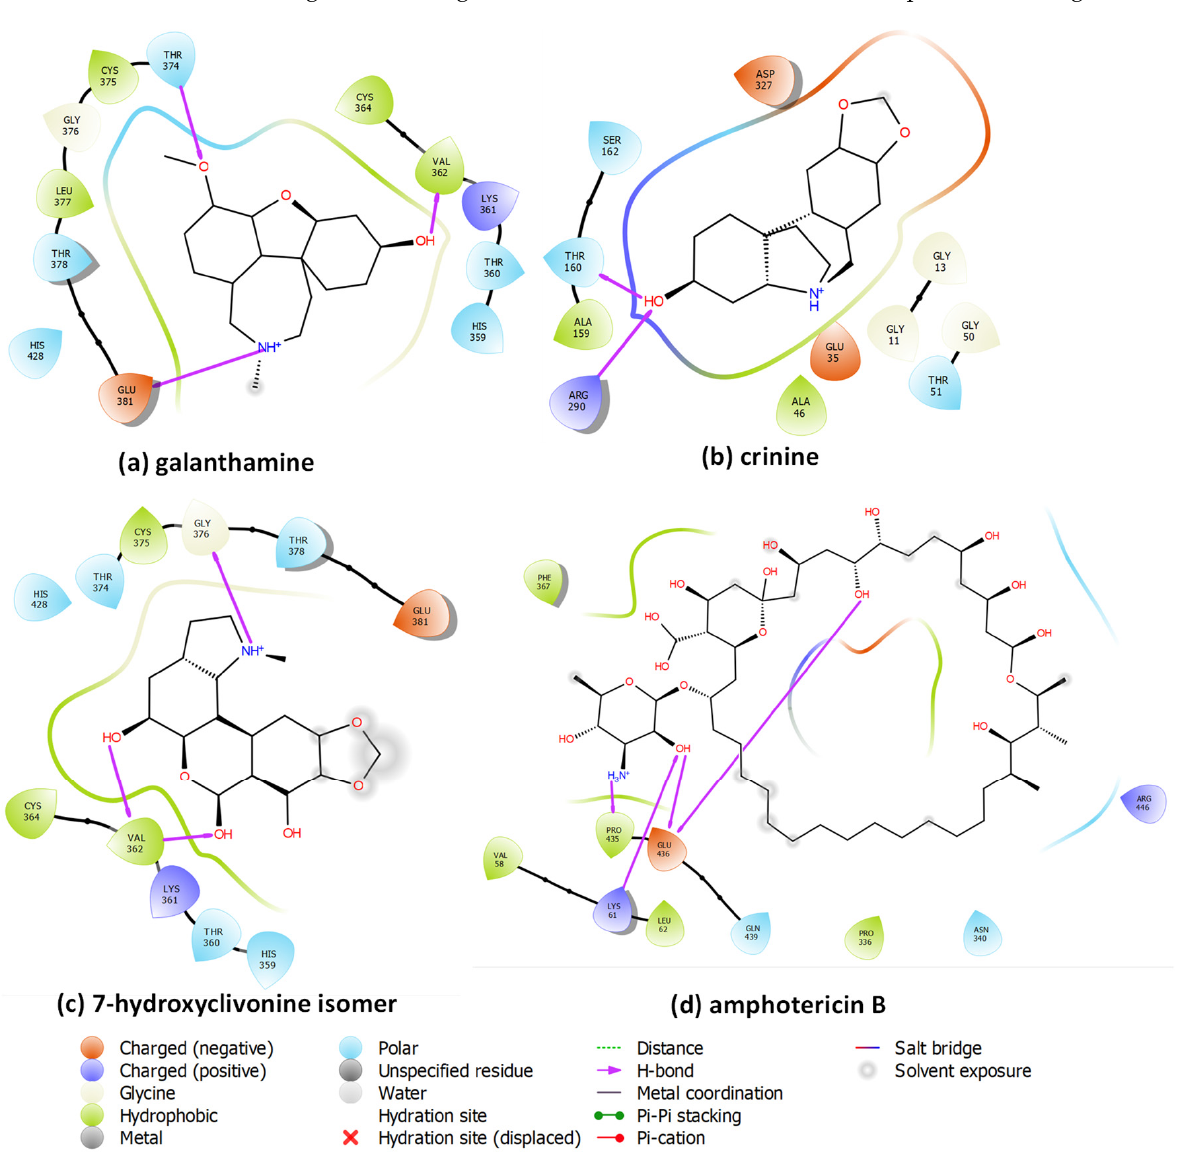
Figure 5. Ligand–protein complexes between the most stable alkaloids and Leishmania braziliensis model determined by the molecular docking procedure.